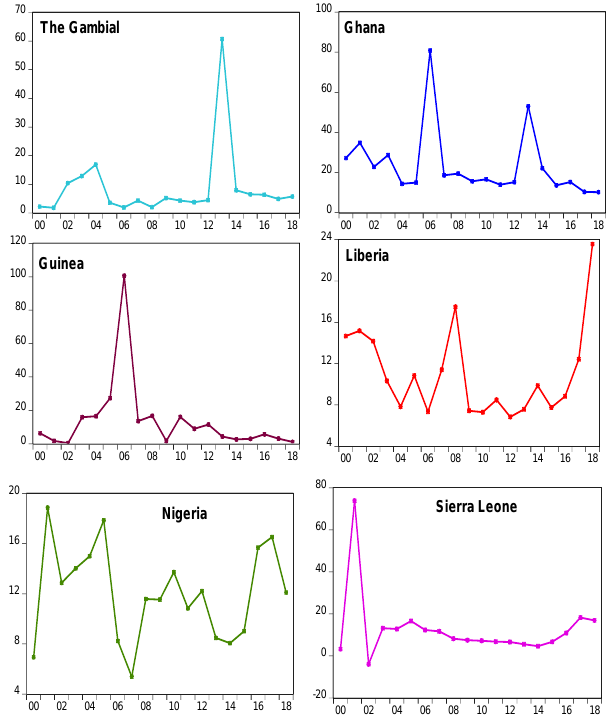
Figure 2: The Nature of Domestic Prices in the Selected